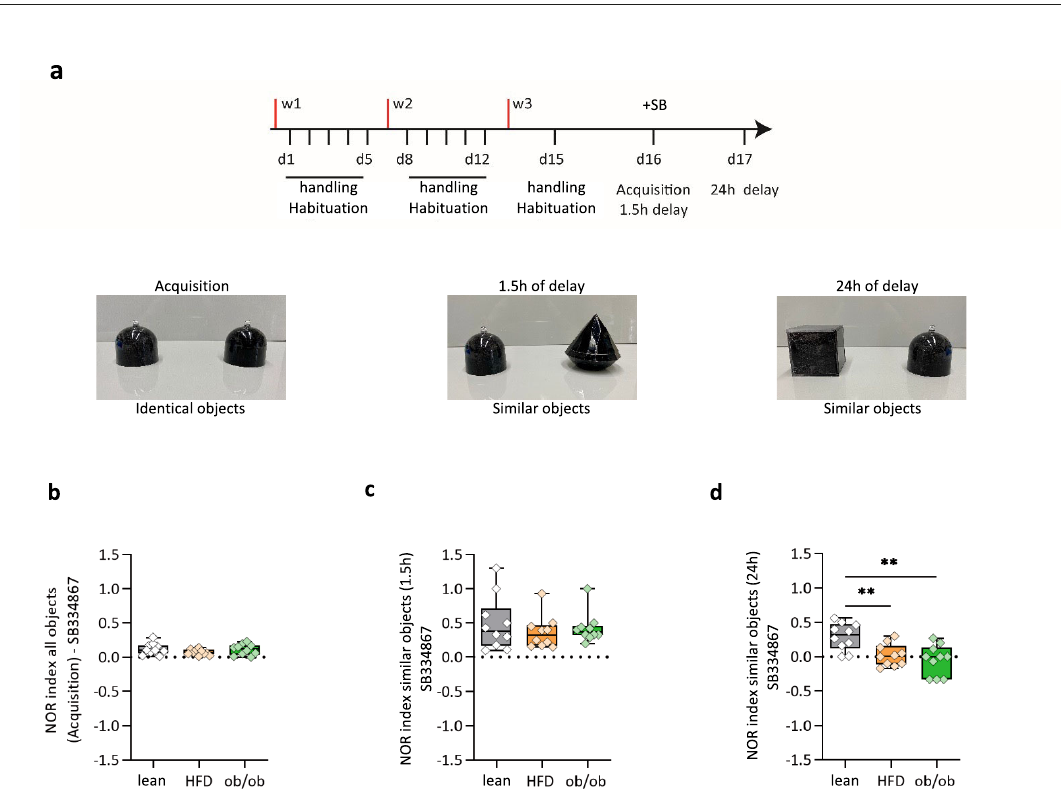
Fig. 7 OxA-mediated impairment of AHN and plasticity of MPP-DG occurs via 2-AG/CB1 signaling. a Plot of the fEPSP slope recorded in brain slice of lean mice before and after the induction of the LTP (time 0) in lean mice, OxA 200 nM + AM251, OxA 200 nM + O7460, ACEA. n = 10 slices (control), n = 8 slices (OxA + AM251), n = 7 slices (OxA + O7460), n = 9 slices (ACEA) from n = 5 mice/treatment; data are presented as mean values ± SEM. b Box plot of the LTP in the four experimental conditions. n = 10 slices control, n = 8 from OxA + AM251, n = 7 OxA + O7460, n = 9 ACEA from fi ve mice each. Slope 40 − 60 min post HFT in lean mice = 120.5%± 6.9%; AM251 (4 µ M) 40 − 60 min post HFT: 135.8% ± 14.83%; O-7460 (10 µ M) slope 40 − 60 min post HFT: 121.1%± 11.82%; ACEA (125 nM) slope 40 − 60 min post HFT: 84.73% ± 5.5%. Kruskal − Wallis test and post hoc Dunn ’ s multiple comparison test, * p < 0.05, Kruskal − Wallis statistic = 11.69. c Plot of the fEPSP slope recorded in vivo before and after the induction of the LTP in HFD mice (time 0), n = 4 mice per group, data are presented as mean values± SEM. d Box plot of the LTP in the three experimental conditions in HFD mice, HFD + SB (SB — 0.1 nmol/0.5 μ l) and HFD + AM251 (0.5 nmol/0.5 μ l). 195.7%± 30.39% of the LTP baseline for HFD + SB; 109.4% ± 4.7% of the LTP baseline in HFD + AM251; Kruskal − Wallis test and post hoc Dunn ’ s multiple comparison test, * p < 0.05, Kruskal − Wallis statistic = 8, n = 4 mice per group. e Plot of the fEPSP slope recorded in vivo before and after the induction of the LTP (time 0) in ob/ob mice. n = 5 vehicle-injected, n = 4 SB-injected and n = 4 AM251-injected ob/ob mice; data are presented as mean values± SEM. f Box plot of the LTP in the three experimental conditions in ob/ob mice, ob/ob + SB (SB — 0.1 nmol/0.5 μ l) and ob/ob + AM251 (0.5 nmol/0.5 μ l). LTP was 175.6% ± 3.77% in ob/ob + SB and 190% ± 21.5% in ob/ob + AM251. n = 5 ob/ob, n = 4 ob/ob + SB, n = 4 ob/ob + AM251 Kruskal − Wallis test and post hoc Dunn ’ s multiple comparison test, * p < 0.05, Kruskal − Wallis statistic = 8.69. The box plots elements are: center line, median (Q2); square symbol, mean; box limits, 25th (Q1) − 75th (Q3) percentiles; whisker length is determined by the outermost data points. g − i NR2B downregulation in DG of obese mice. Confocal images of DCX/PSD95/NR2B immunolabeling of DG in lean ( g ), obese HFD ( h ), and ob/ob ( i ) mice showing a wide density of distribution of NR2B-ir (blue) at IML-MML DG of lean mice and colocalization with PSD95-ir (red) at postsynaptic side of DCX-ir dendritic spines. Scale bar: 10 µ m. Immunolabeling was repeated n = 3 times independently in different DG sections from n = 6 mice per group, with similar results. j , k Measurement of NR2B subunit expression. Effect of leptin on NR2B subunit expression in lean, ob/ob, and HFD mice treated with or without leptin evaluated by western blot analysis. j Representative blot showing the band intensity of NR2B subunit in the aforementioned experimental mice. k Bar graphs showing the quanti fi cation of phospho-NR2B subunit normalized to α -tubulin. Data represent the means ± SEM from n = 3 mice/group. Data sets were compared by one-way ANOVA followed by Tukey ’ s test, * p < 0.05, *** p < 0.001, F = 10.63. Source data are provided as a Source Data fi le.